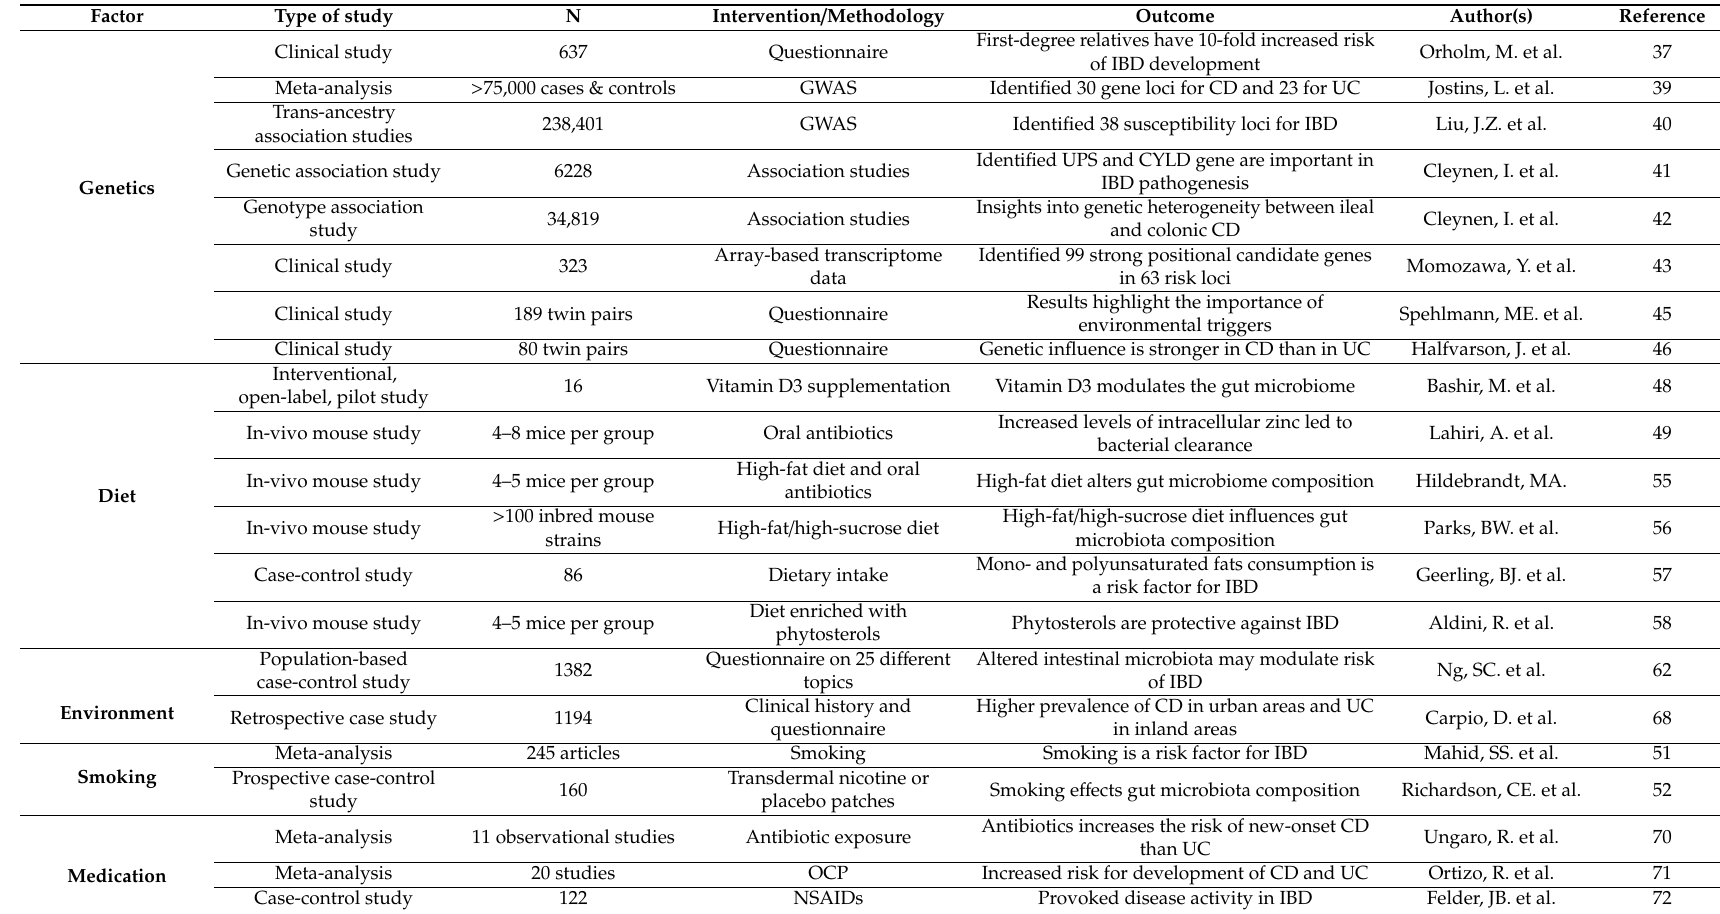
Table 1. Factors involved in the gut / microbiota / brain interplay in inflammatory bowel disease (IBD)